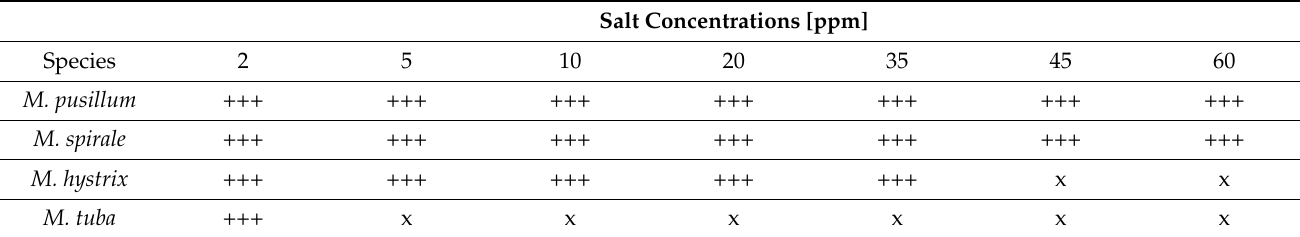
Table 1. Adhesion assay in different salt concentrations.